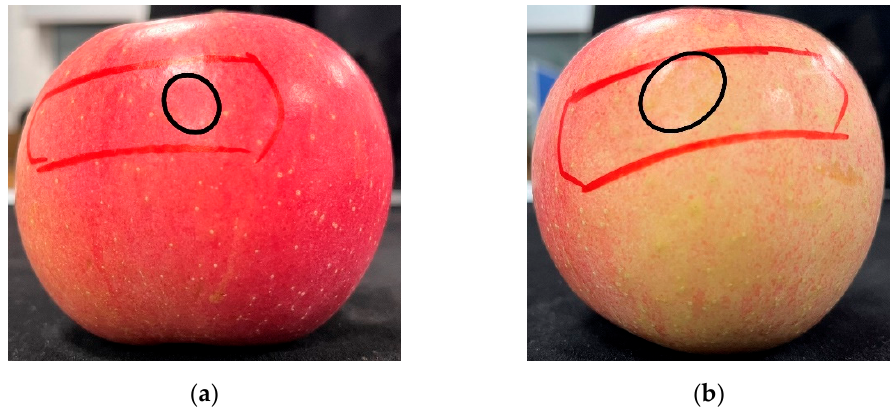
Figure 25. Specific damage to apple pericarp: ( a ) slightly damaged; ( b ) severely damaged.